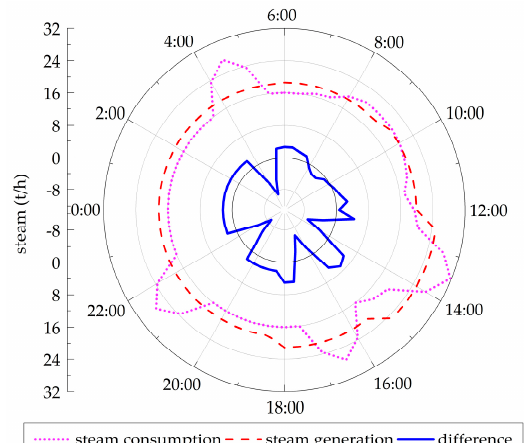
Figure 12. Load diagram of the optimal operation scheme. The dashed line denotes the steam